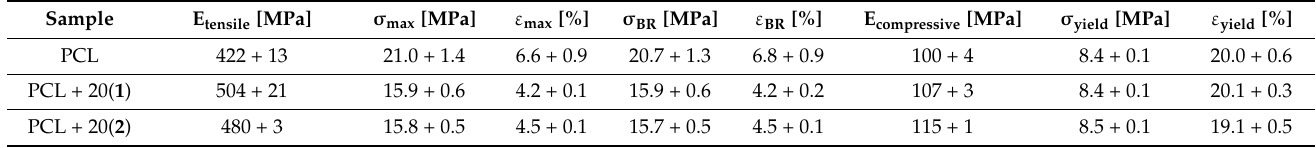
Table 3. The results of composite fittings mechanical strength and compressive strength studies in the static tensile test. Sample